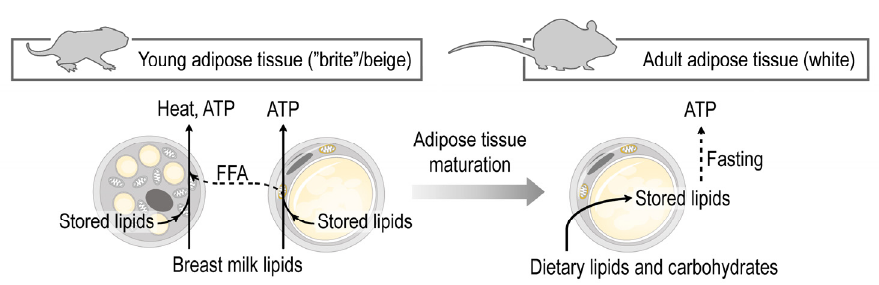
Figure 6. Maturation of the subcutaneous adipose tissue entails a shift from fat catabolism and thermogenesis to fat storage. The subcutaneous adipose tissue in early postnatal life shows hallmarks of beige adipocytes, and supports the catabolism of dietary lipids, mostly breast milk lipids. At this developmental stage the fat is catabolized by the adipocytes to elaborate free fatty acids (FFA), produce energy and heat. Breast milk lipid mediators maintain beige adipocytes. In adulthood, however, the subcutaneous adipose tissue is predominantly a lipid storage